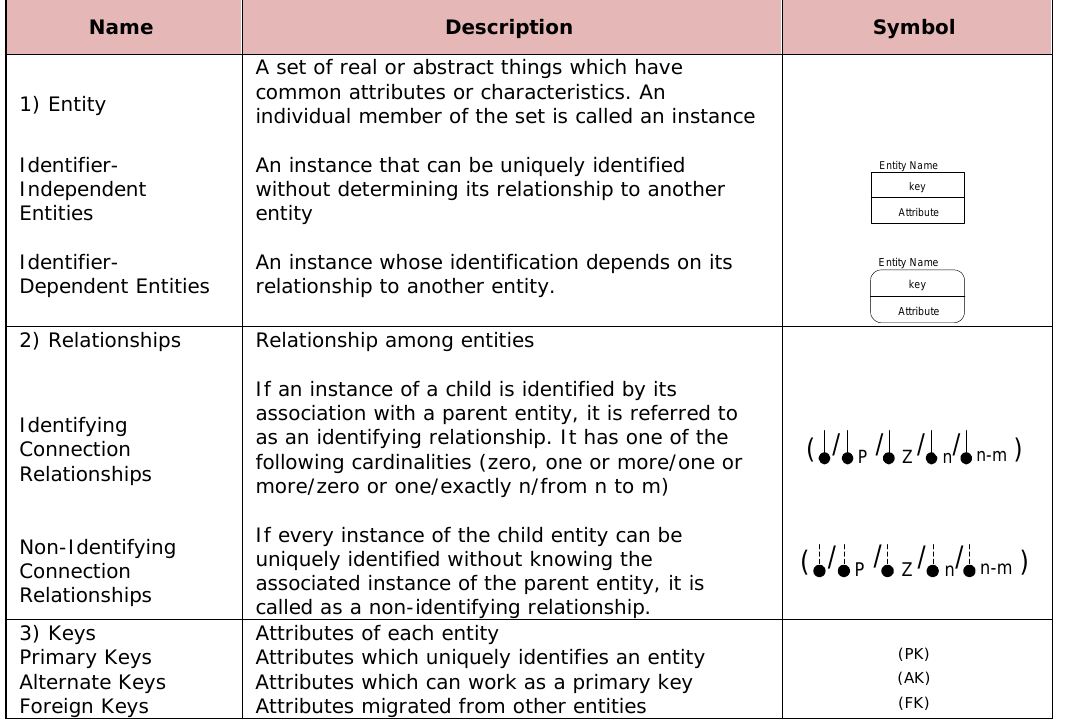
Figure 4. “IDEF1X building blocks and symbols”.